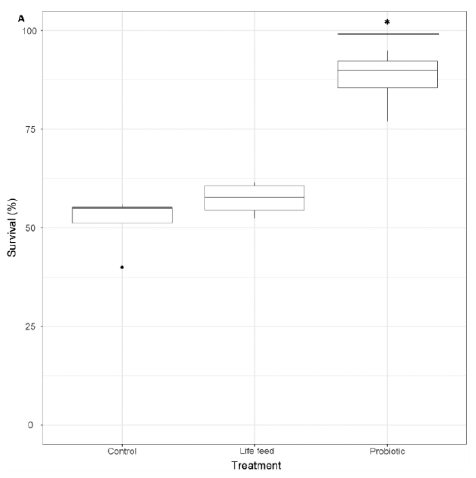
Figure 4. A: Larval survival percentage ( n = 100), after 21 dph. Dots shown are the out layers, whiskers indicate the maximum and minimum values excluding out layers, the line in the middle of box is the median value and upper and lower quartiles are the ends of the box. Statistically significant differences between treatments are marked with an asterisk. Statistically significant differences between samples are marked with an asterisk.